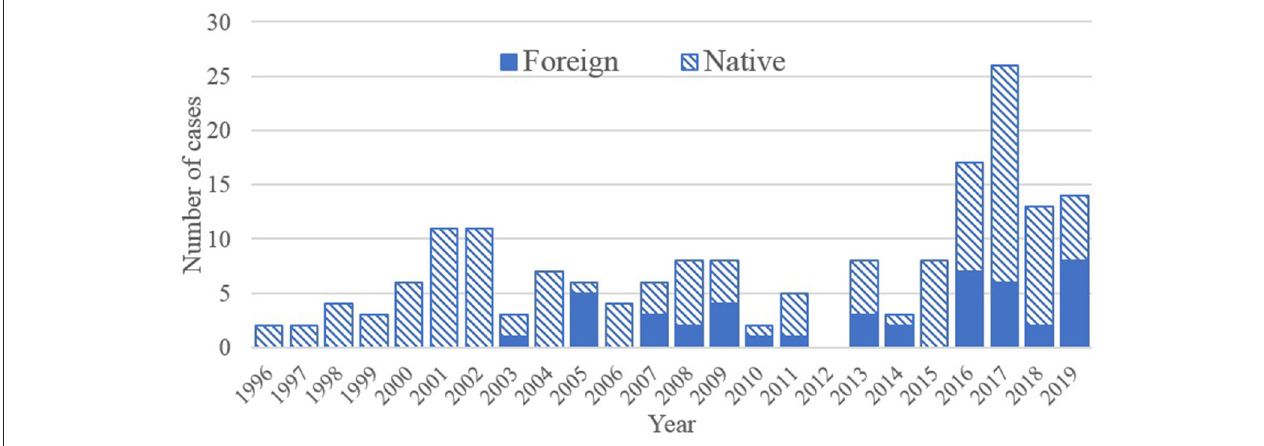
FIGURE 1 | Total number of cases of leishmaniasis, in Spanish born population (native) and foreigner country of birth, in Barcelona between 1996 and 2019 ( n = 177 cases).